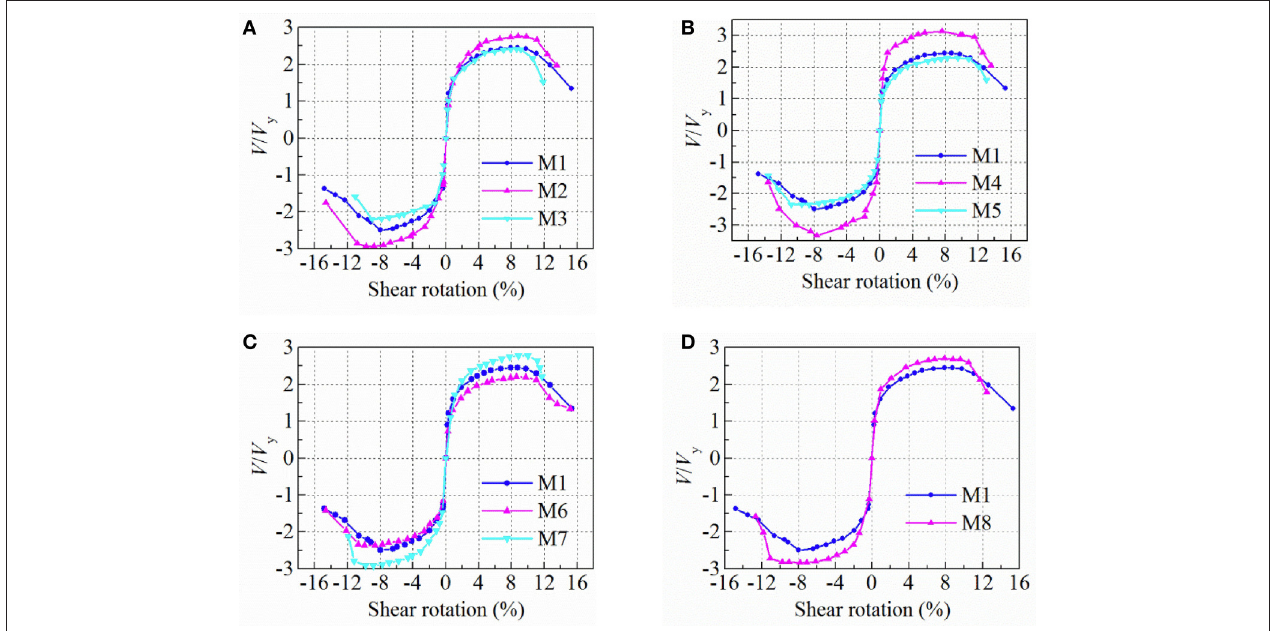
FIGURE 6 | Normalized shear force-shear rotation envelope curves: (A) different web steel; (B) different specimen length; (C) different web depth; (D) different detailing.